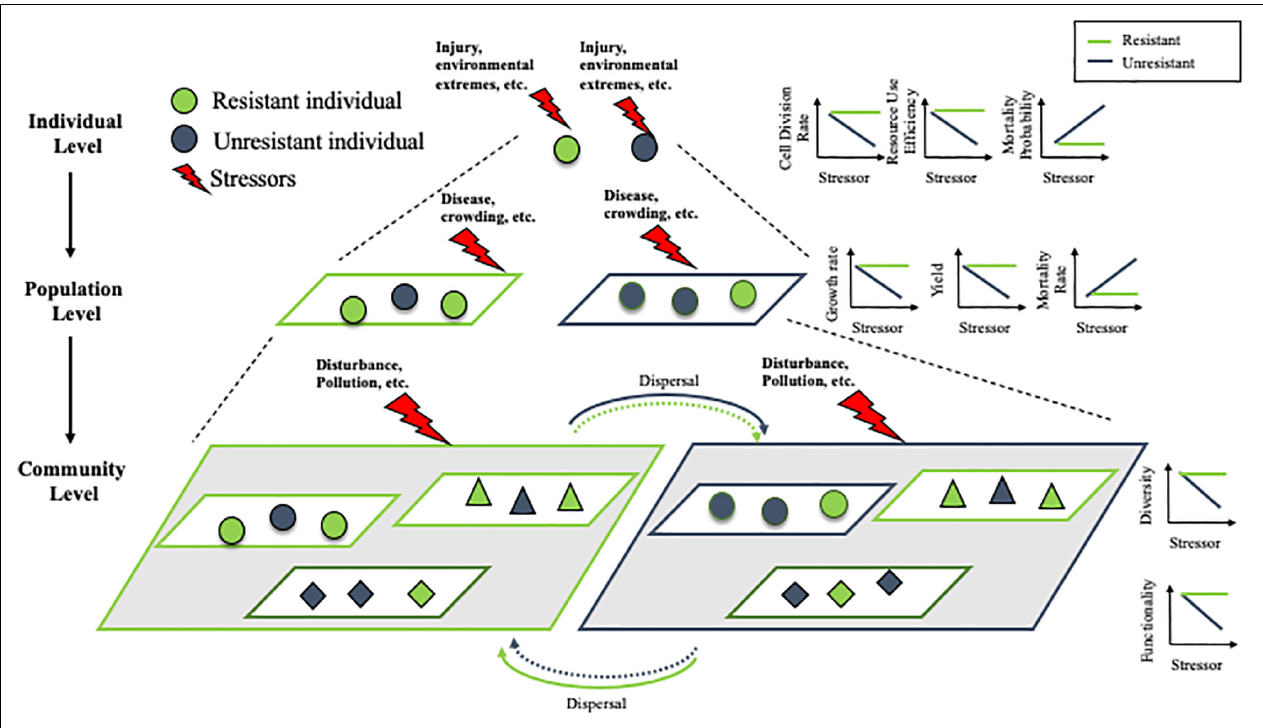
FIGURE 1 | Scaling the effect of stressors from individuals to communities. We hypothesize the resistant individuals (green) are less sensitive to stressor impact at the individual level (cell division rate, resource use efficiency and mortality probability). Populations composed primarily of resistant individuals are similarly more resistant (growth rate, yield, and mortality rate) than populations with a majority of non-resistant (charcoal gray) individuals. This trend continues to scale to the community level, where communities with a larger number of resistant populations of various species (triangles, diamonds, circles) are more resistant (diversity, functionality) than communities with fewer resistant populations of the same species. When there is dispersal between communities, resistant individuals are more likely to disperse into preferable, resistant communities, while non-resistant individuals may be more likely to disperse into suboptimal, non-resistant